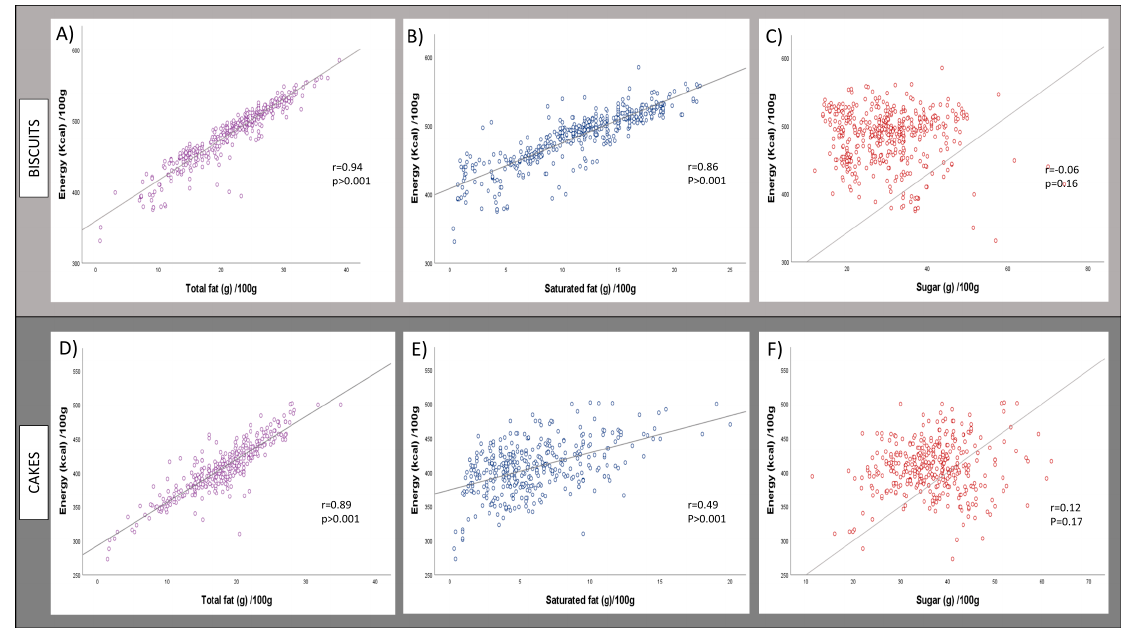
Figure 6. Correlations between total fat, saturated fat and sugar (g/100) and energy density (kcal/100 g) in biscuits ( A – C ) and cakes ( D – F ).